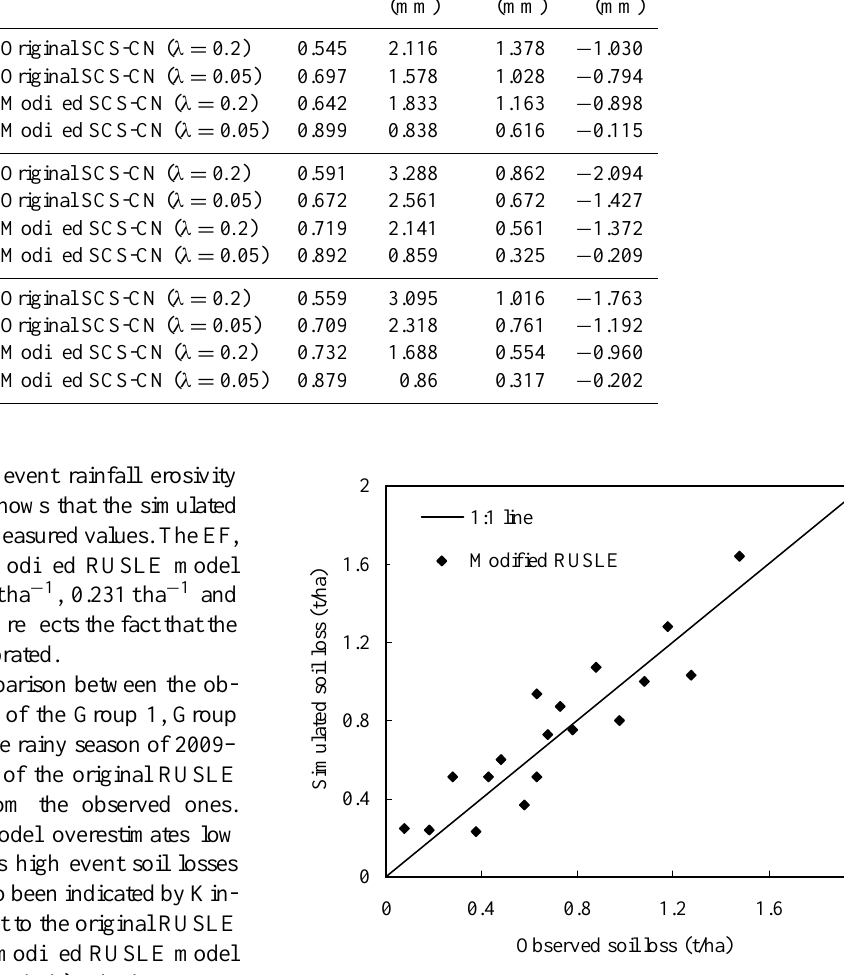
Fig. 6. Comparison between observed and simulated event soil loss using observed data of the three runoff plot groups in 2008 to calibrate the Modified RUSLE model